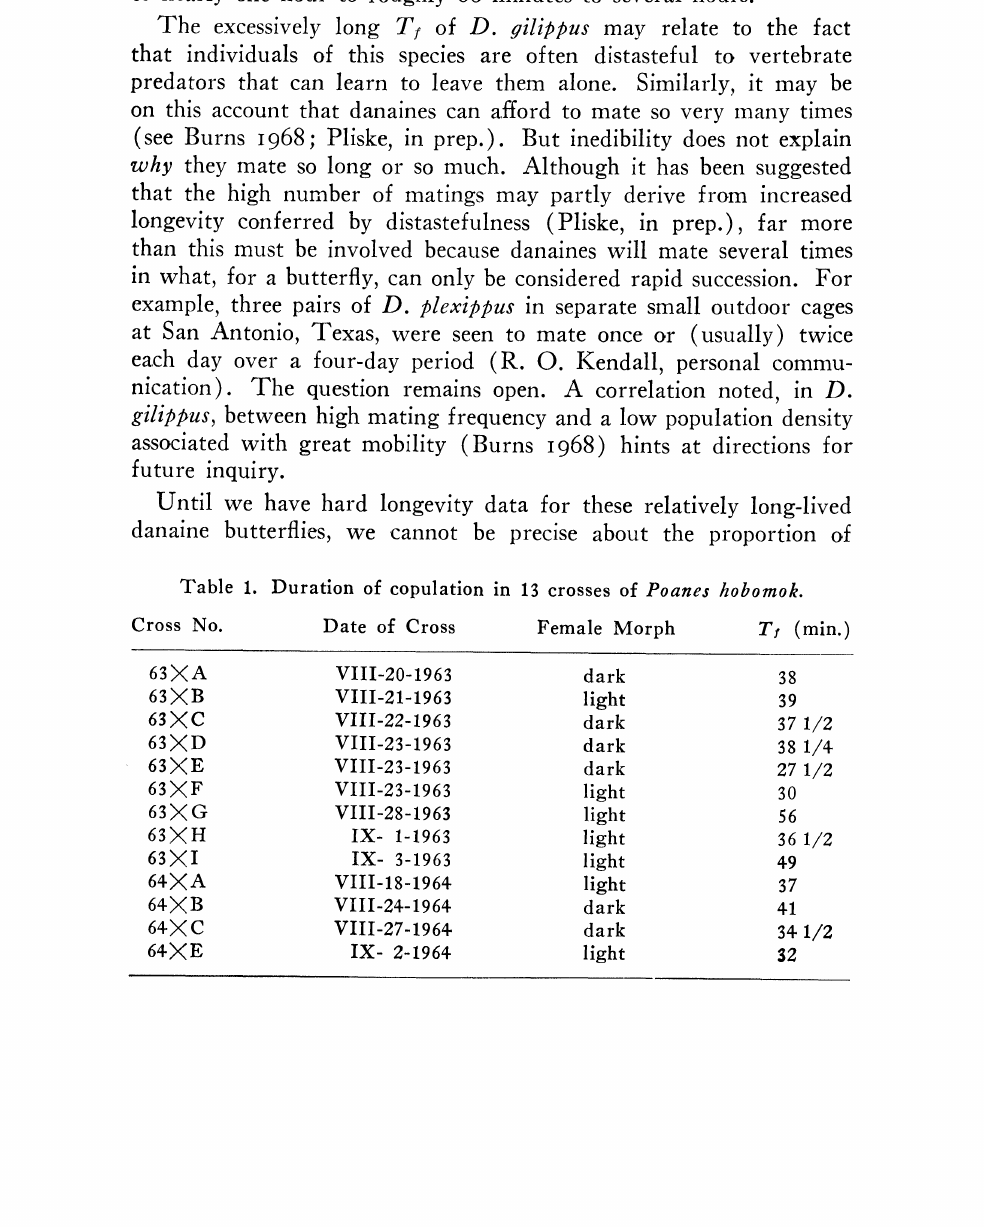
Table 1. Duration of copulation in 13 crosses of Poanes hobomok. Cross